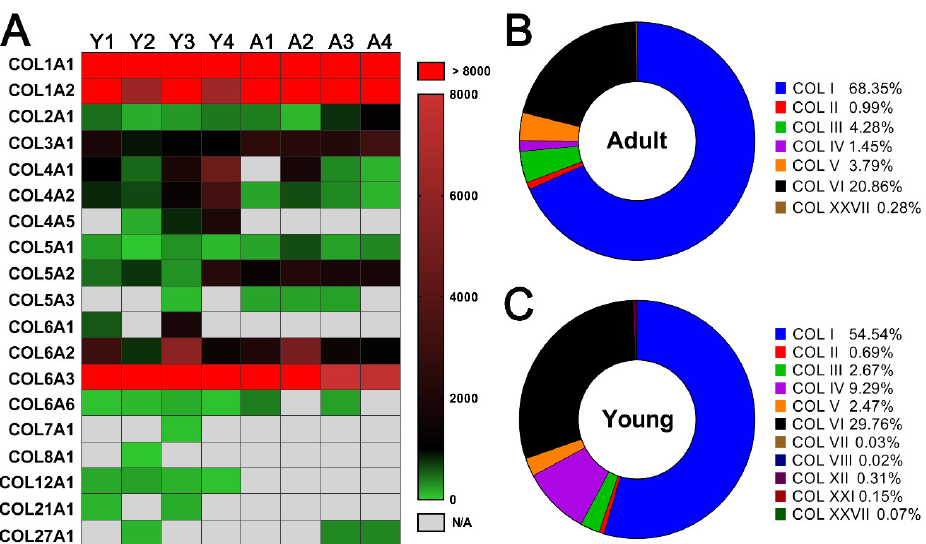
Figure 4. Comparison of collagen contents in young and adult dpECM. ( A ) Heatmap of collagens identified in young (Y1–Y4) ( n = 4) and adult (A1–A4) ( n = 4) dpECM. Columns represent individual dpECM. The relative abundance of each molecule is depicted by a color code. Undetected collagens are shown in grey. ( B , C ) Average percentage of individual collagen type in the total abundance of collagens in adult ( B ) and young ( C ) dpECM.